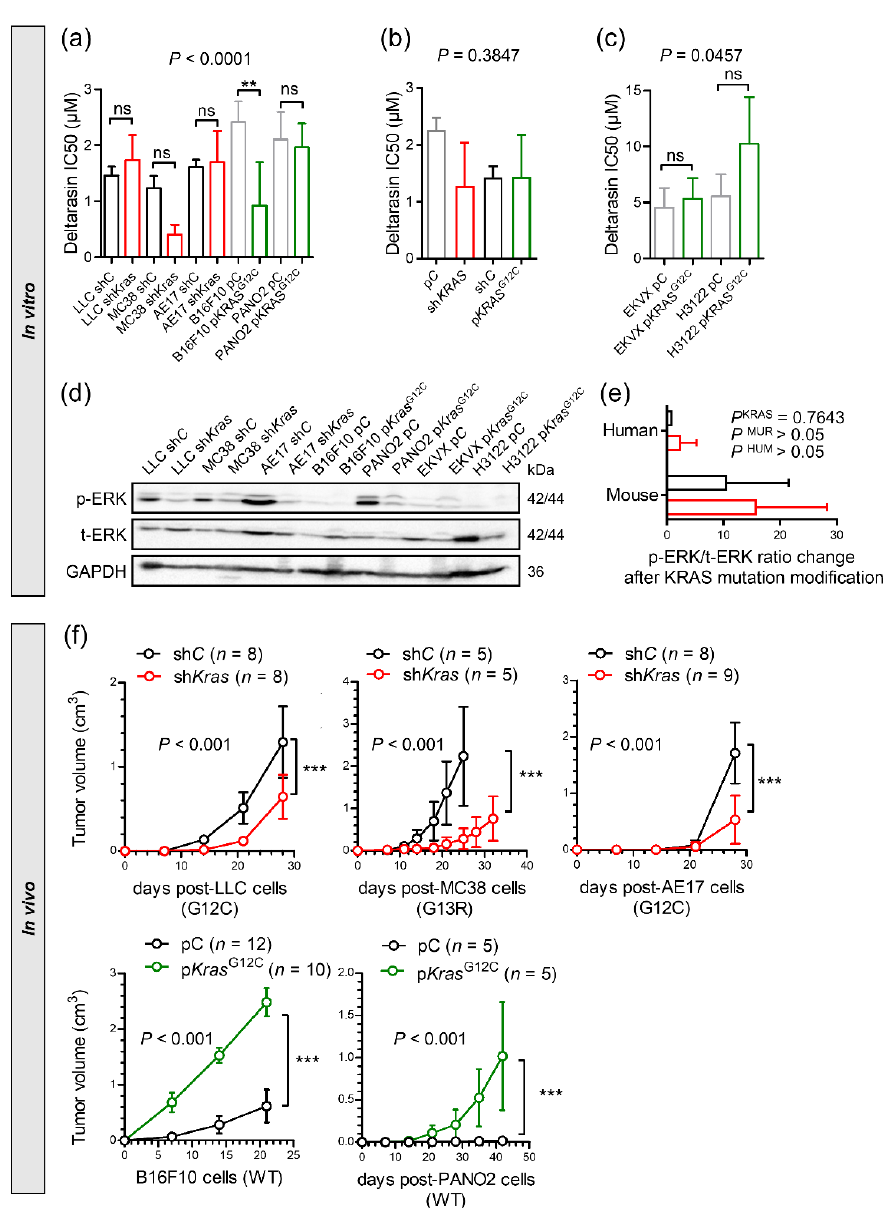
Figure 3. Genetic manipulation of Kras reveals in vivo-restricted KRAS dependence. ( a ) Different murine parental (black/grey: stably expressing random shRNA, sh C , or control plasmid, p C ) or Kras -modified (red: stably expressing sh Kras ; green: stably expressing mutant Kras G12C plasmid, p Kras G12C ) tumor cell lines were assessed for cell viability (IC 50 via WST-8-assay; n = 2 – 4/data-point) after 72 h of deltarasin treatment. ( b ) Summary of averaged deltarasin IC 50 values from all cell lines from ( a ) ( n = 2-3 cell lines/group). ( c ) Human parental (black/grey: stably expressing control plasmid p C ) or KRAS -modified (green: stably expressing p Kras G12C ) tumor cell lines were assessed for cell viability via WST-8 assay ( n = 2 – 5/data-point) after 72 h of deltarasin treatment. ( d ) Immunoblots of cell lines from ( a ) for p-ERK, t-ERK and GAPDH. ( e ) Quantification of normalized p-ERK/t-ERK signal from ( d ). Data were summarized by mutation status and origin. ( f ) The five cell line doublets from ( a ) were injected into the rear flank (10 6 tumor cells sc) of C57BL/6 mice for induction of flank tumors via genetically modified cells (red, sh Kras ; green, p Kras G12C ) or control cells (black, sh C or p C ). p , overall probability according to one-way ( a - c ) and two-way ( e,f ) ANOVA. ns, **, and ***: p > 0.05, p < 0.01, and p < 0.001, respectively, for the indicated comparisons via Bonferroni post-tests. Data are presented as mean ± SD.